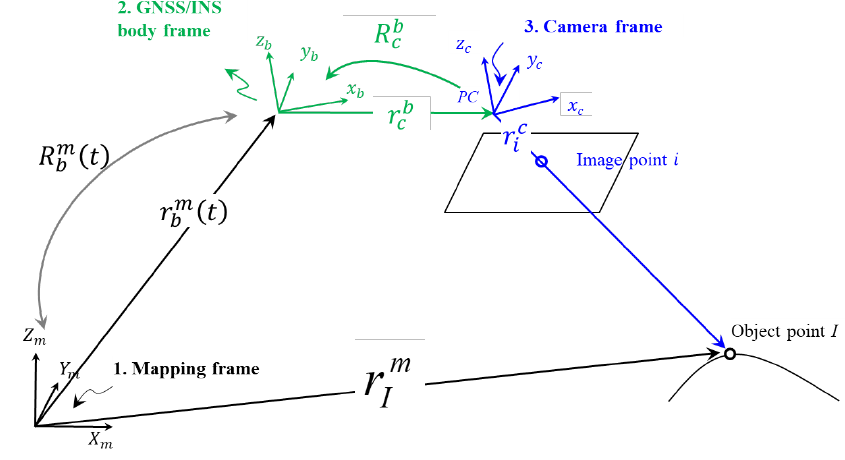
Figure 3. Illustration of collinearity equations.